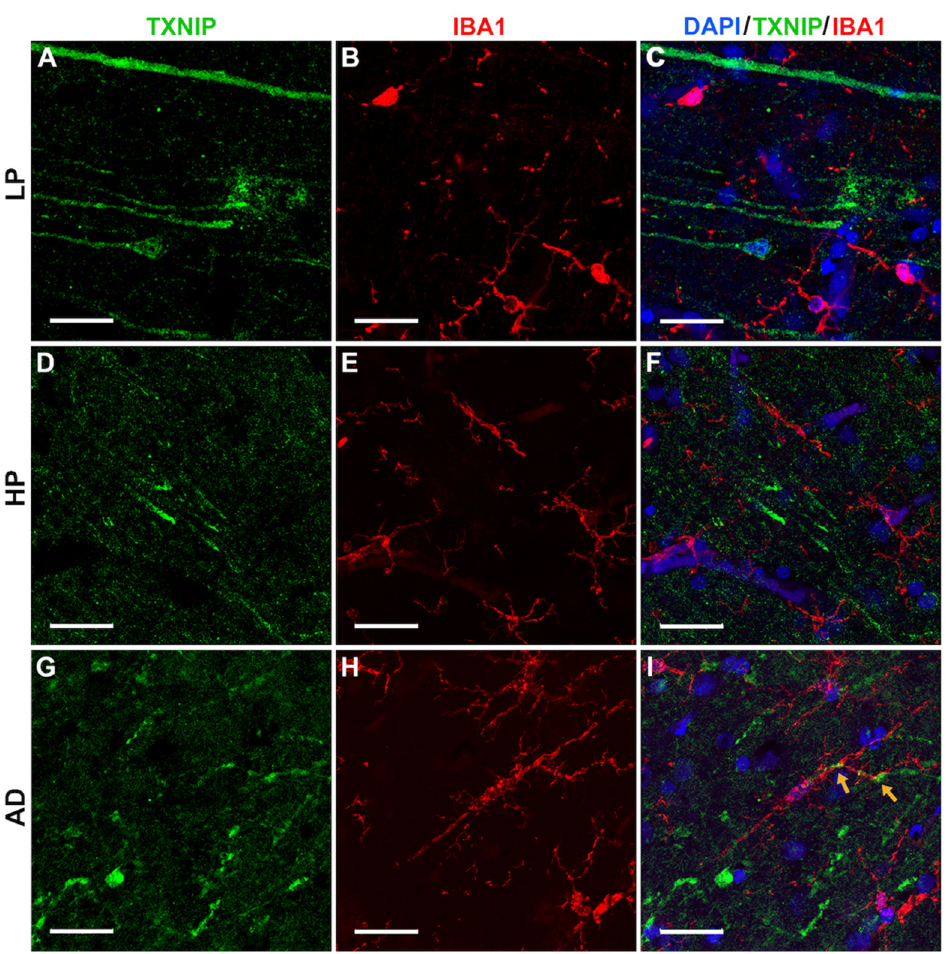
Figure 7. Confocal microscopy showing limited colocalization of TXNIP with microglia marker IBA-1 immunoreactivity. All sections shown were from middle temporal gyrus. ( A – C ) LP case showing ( A ) TXNIP immunoreactivity (green), ( B ) IBA-1 immunoreactivity (red), and ( C ) merged image with DAPI staining (blue). ( D – E ) HP case showing ( D ) TXNIP im- munoreactivity (green), ( E ) IBA-1 immunoreactivity (red), and ( F ) merged image with DAPI staining (blue). ( G – I ) AD case showing ( G ) TXNIP immunoreactivity (green), ( H ) IBA-1 immunoreactivity (red), and ( I ) merged image showing TXNIP- positive cells (green) with limited punctate intracellular colocalization (yellow arrow) with IBA-1 (red arrow) with DAPI staining (blue). Bars represents 30 μ m.